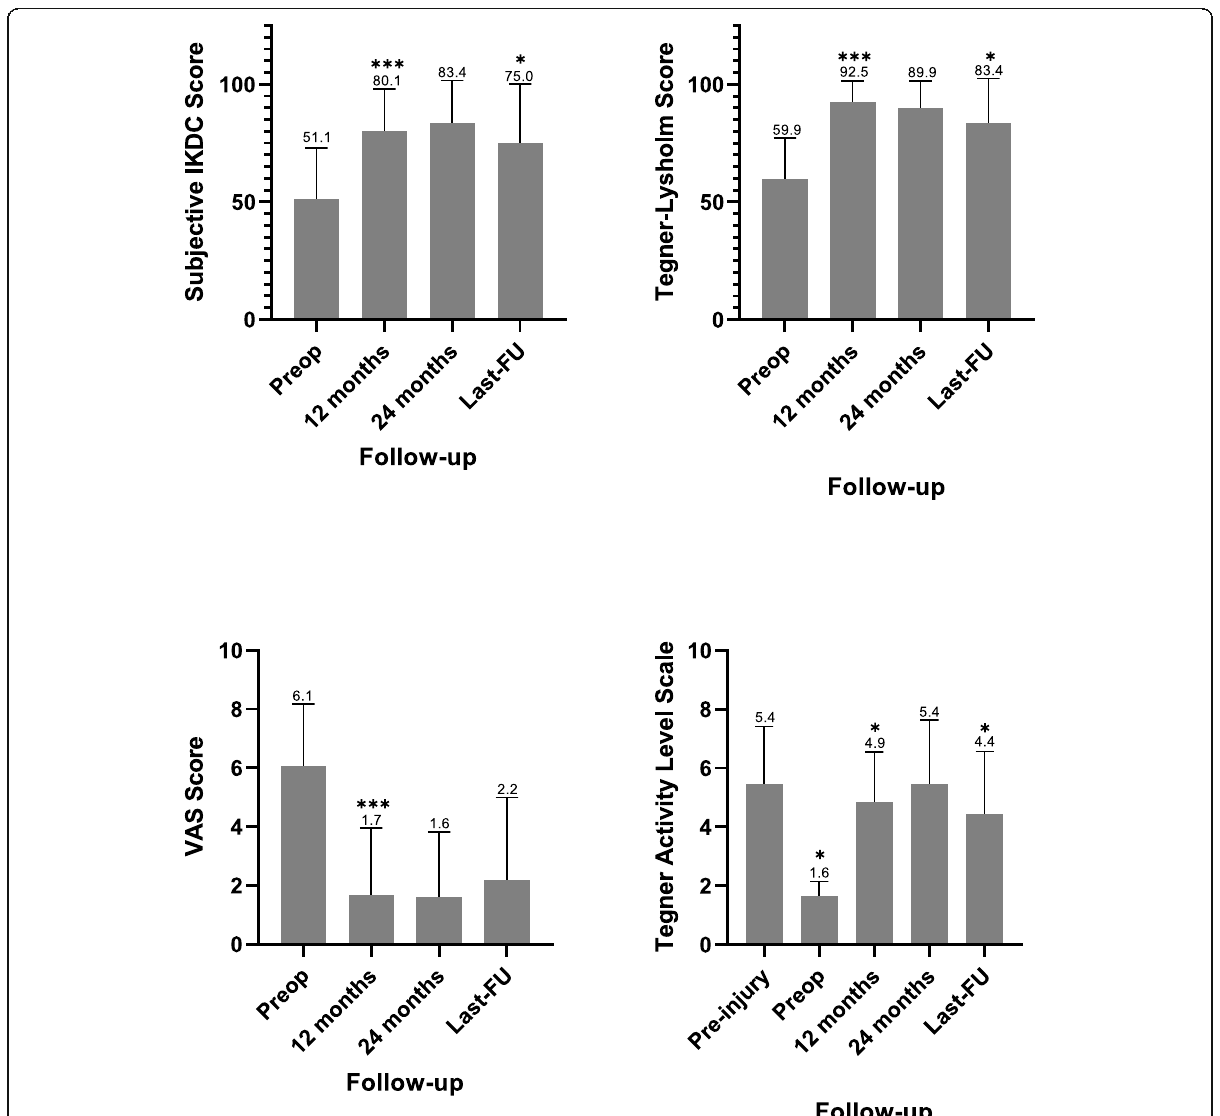
Fig. 2 Outcome evaluation. Mean value of the clinical scores collected preoperatively, at 12 – 24 months after surgery and last follow-up. (* = statistically significant difference, ** = statistically significant difference and minimal clinically important difference, *** = statistically significant difference and minimal clinically important difference and subjective clinical